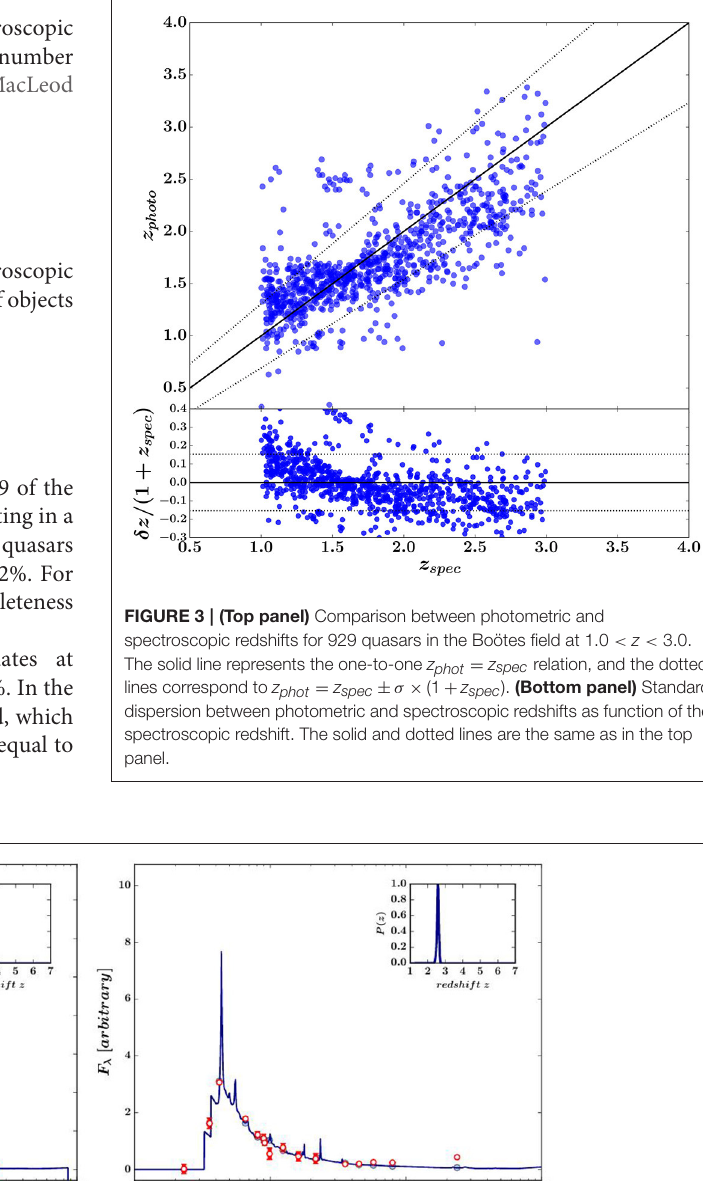
Figure 1 . The colors of the spectroscopic quasars are generally consistent with the proposed color cuts. Figure 4 shows the colors for the 154 candidate quasars selected using our method.